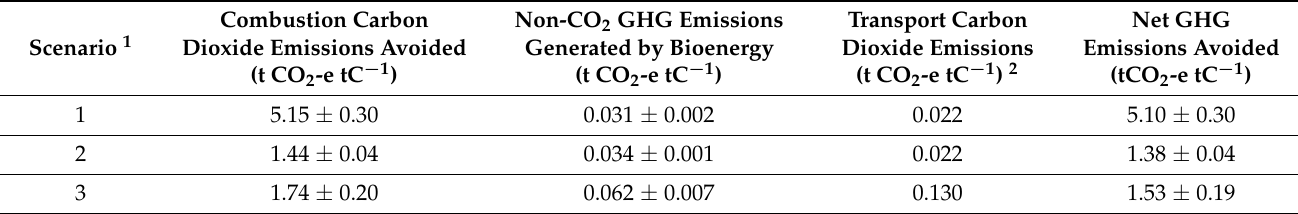
Table 4. Carbon dioxide emissions associated with the combustion of fossil fuel type (avoided), GHG emissions associated with bioenergy (generated), and net GHG emissions avoided.